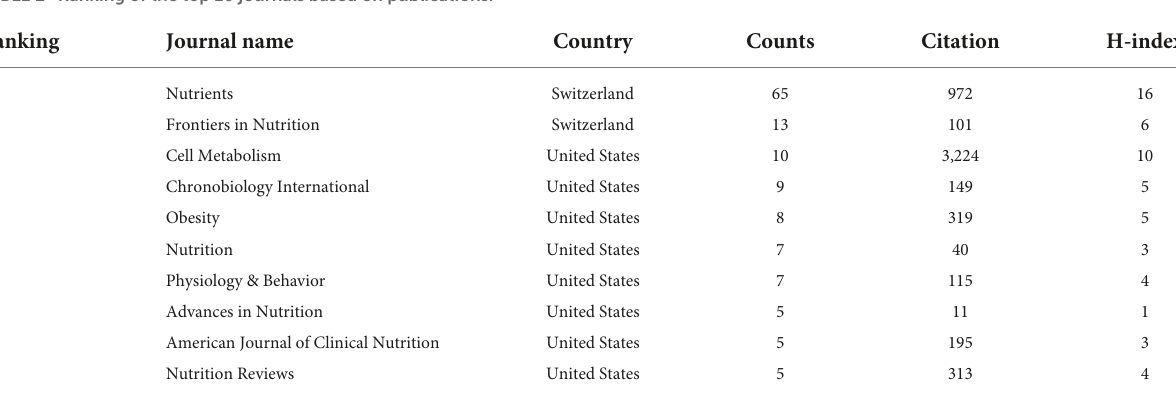
TABLE 2 Ranking of the top 10 journals based on